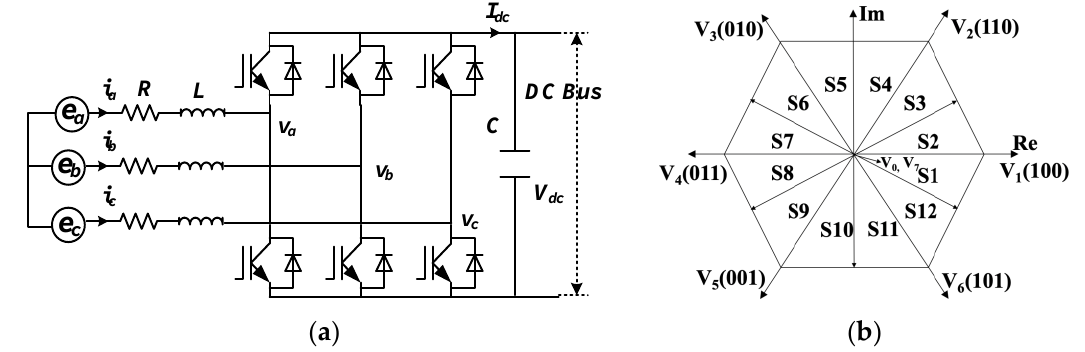
Figure 1. ( a ) AC/DC three-phase converter topology. ( b ) Voltage space vectors.